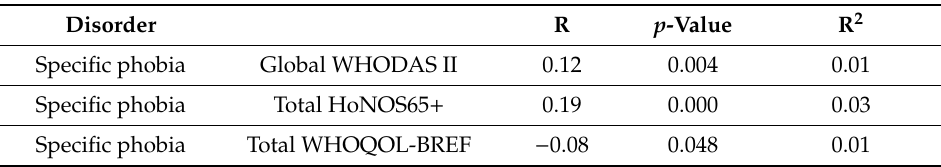
Table 5. Adjusted biserial-point correlations for gender and age (relation between specific phobia disorder and global WHO Disability Assessment Schedule (WHODAS II), total Health of the Nation Outcome Scales for Older Adults (HoNOS65 + ), and total World Health Organization Quality of Life Brief